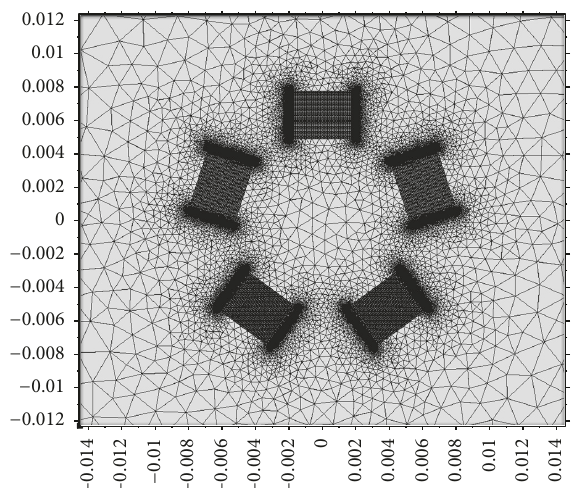
Figure 2: Dependence of the critical current on the angle of the applied magnetic field for several values of applied magnetic field. The symbols are experimental data; the lines show the results of the fits to (2).